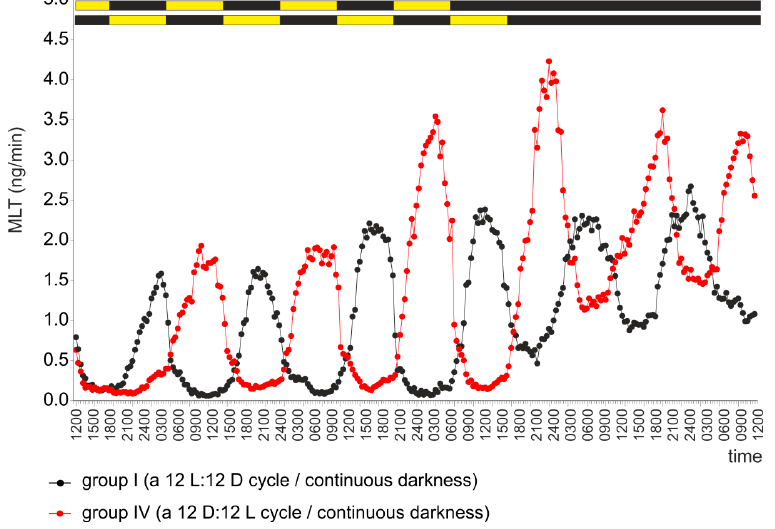
Figure 5. Experiment II. Secretion of MLT (mean) from turkey pineal organs incubated under a 12 L:12 D cycle (group I) and a reversed cycle 12 D:12 L (group III) during four consecutive days and then in continuous darkness.